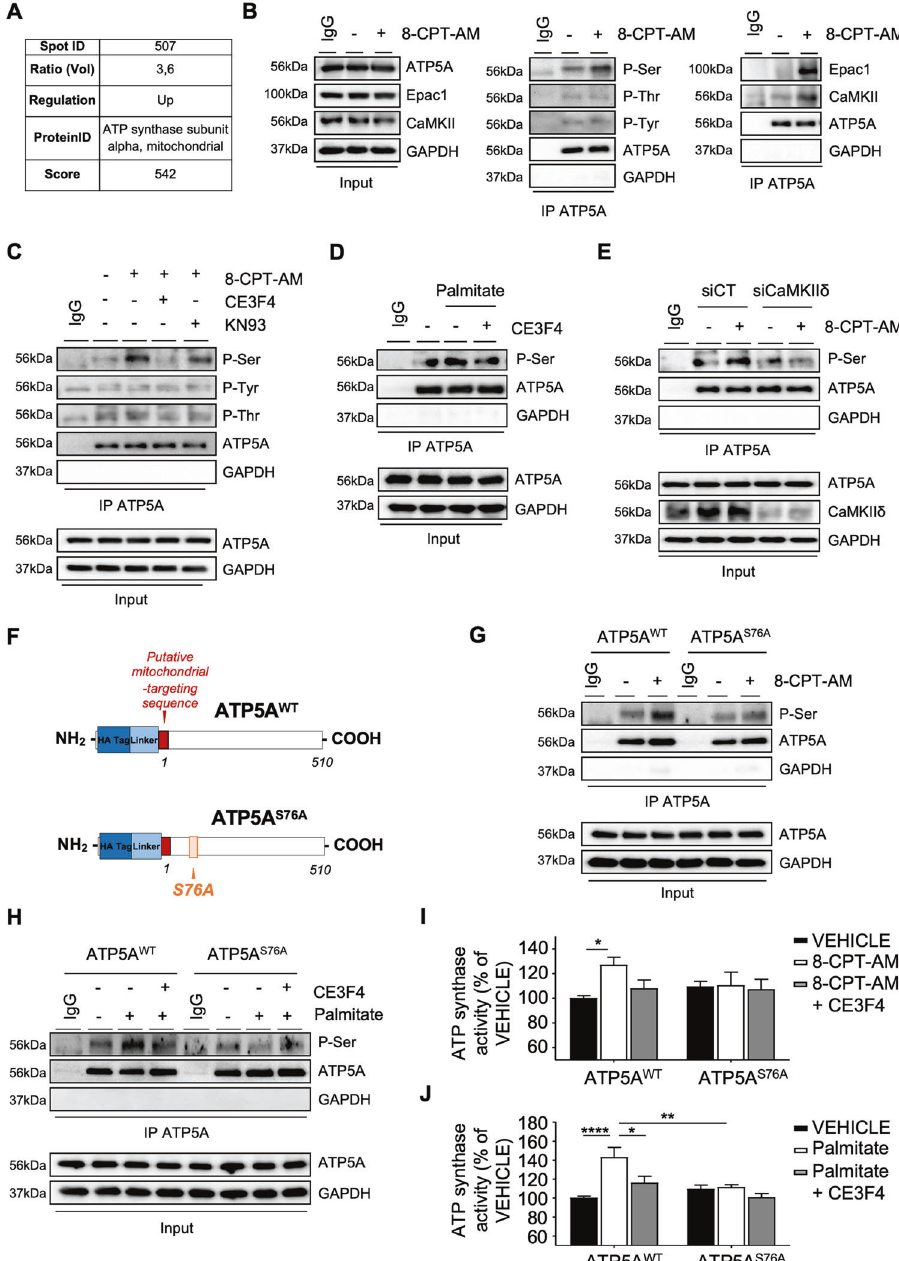
stimulated 8-CPT-AM (10 µM, 10 min) vs. control. ID, identity. B Representative immunoblots showing the interaction of ATP5A with Epac1 or CaMKII, or ATP5A phosphorylation level in cardiomyocytes stimulated or not with 8-CPT-AM (10 µM, 30 min). C, D ATP5A phosphorylation in cells preincubated or not with either CE3F4 (20 µM, 30 min) or KN-93 (5 µM, 30 min) and stimulated or not with either 8-CPT-AM (10 µM, 30 min) or palmitate (500 μ M, 30 min). E ATP5A-dependent serine phosphorylation after CaMKII δ silencing (siCaMKII δ ) or not (siCT)